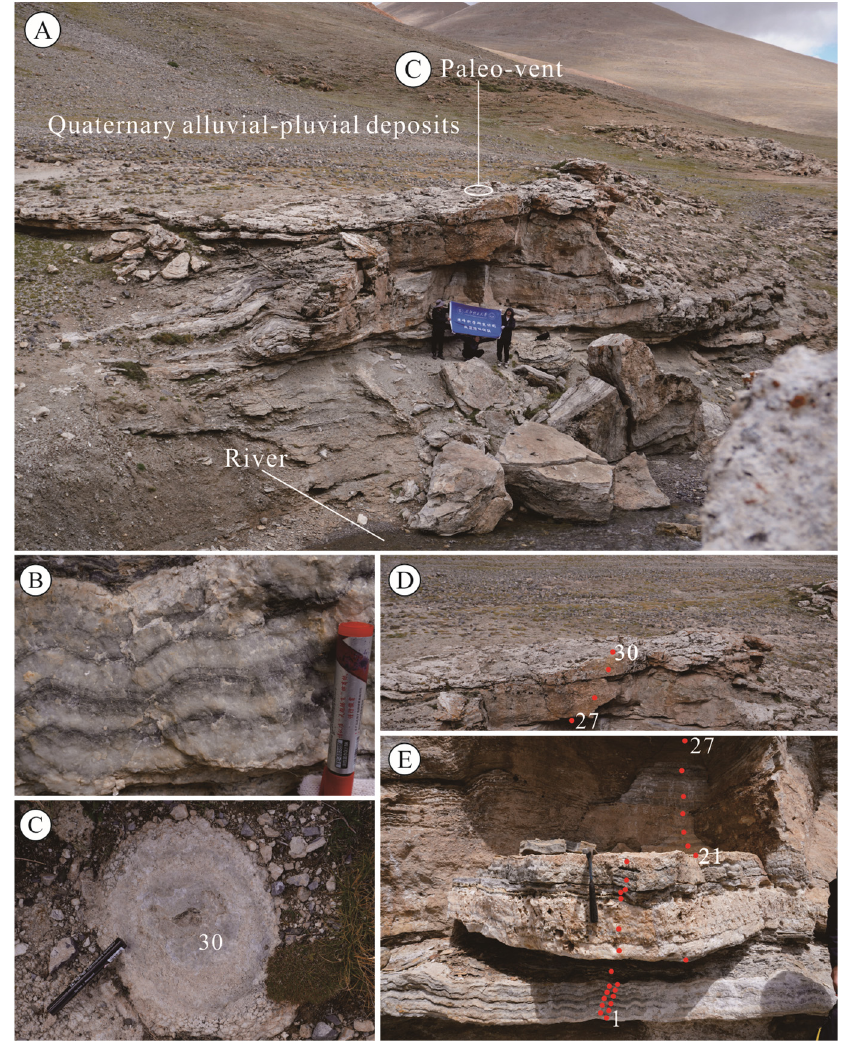
Figure 2. ( A ) General view of the studied travertine mound at Sobcha. ( B ) Nearly horizontal laminated abiotic crystalline crust travertines; ( C ) Paleo-vent situated at the top of the studied travertine mound (its location can be found in panel ( A )). ( D , E ) Schematic diagram of sampling sites of the Sobcha travertines for geochemical analysis. The red dots represent the sample site for geochemical analysis, the number represents the sample number, and the same number represents the same sample.